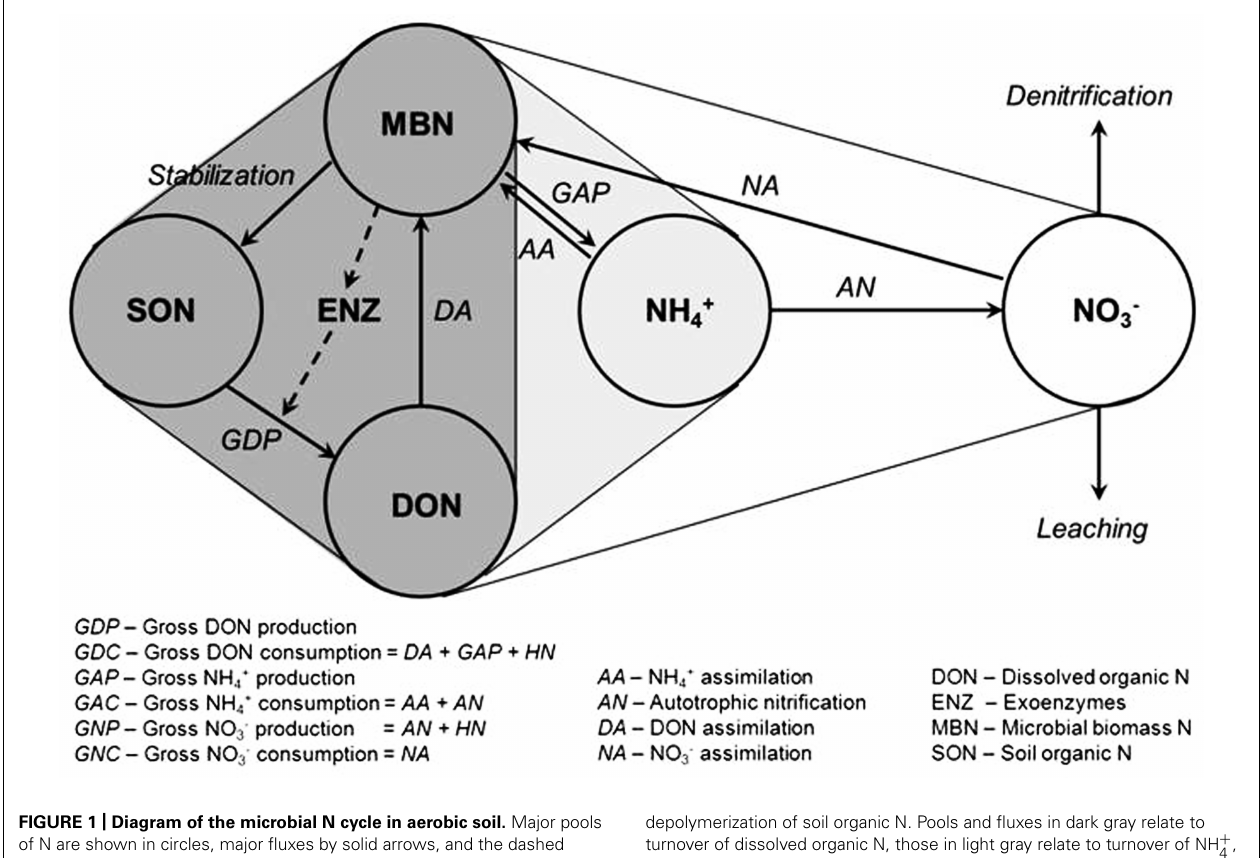
FIGURE 1 | Diagram of the microbial N cycle in aerobic soil. Major pools of N are shown in circles, major fluxes by solid arrows, and the dashed arrow represents the production of exoenzymes (e.g., proteases) for the